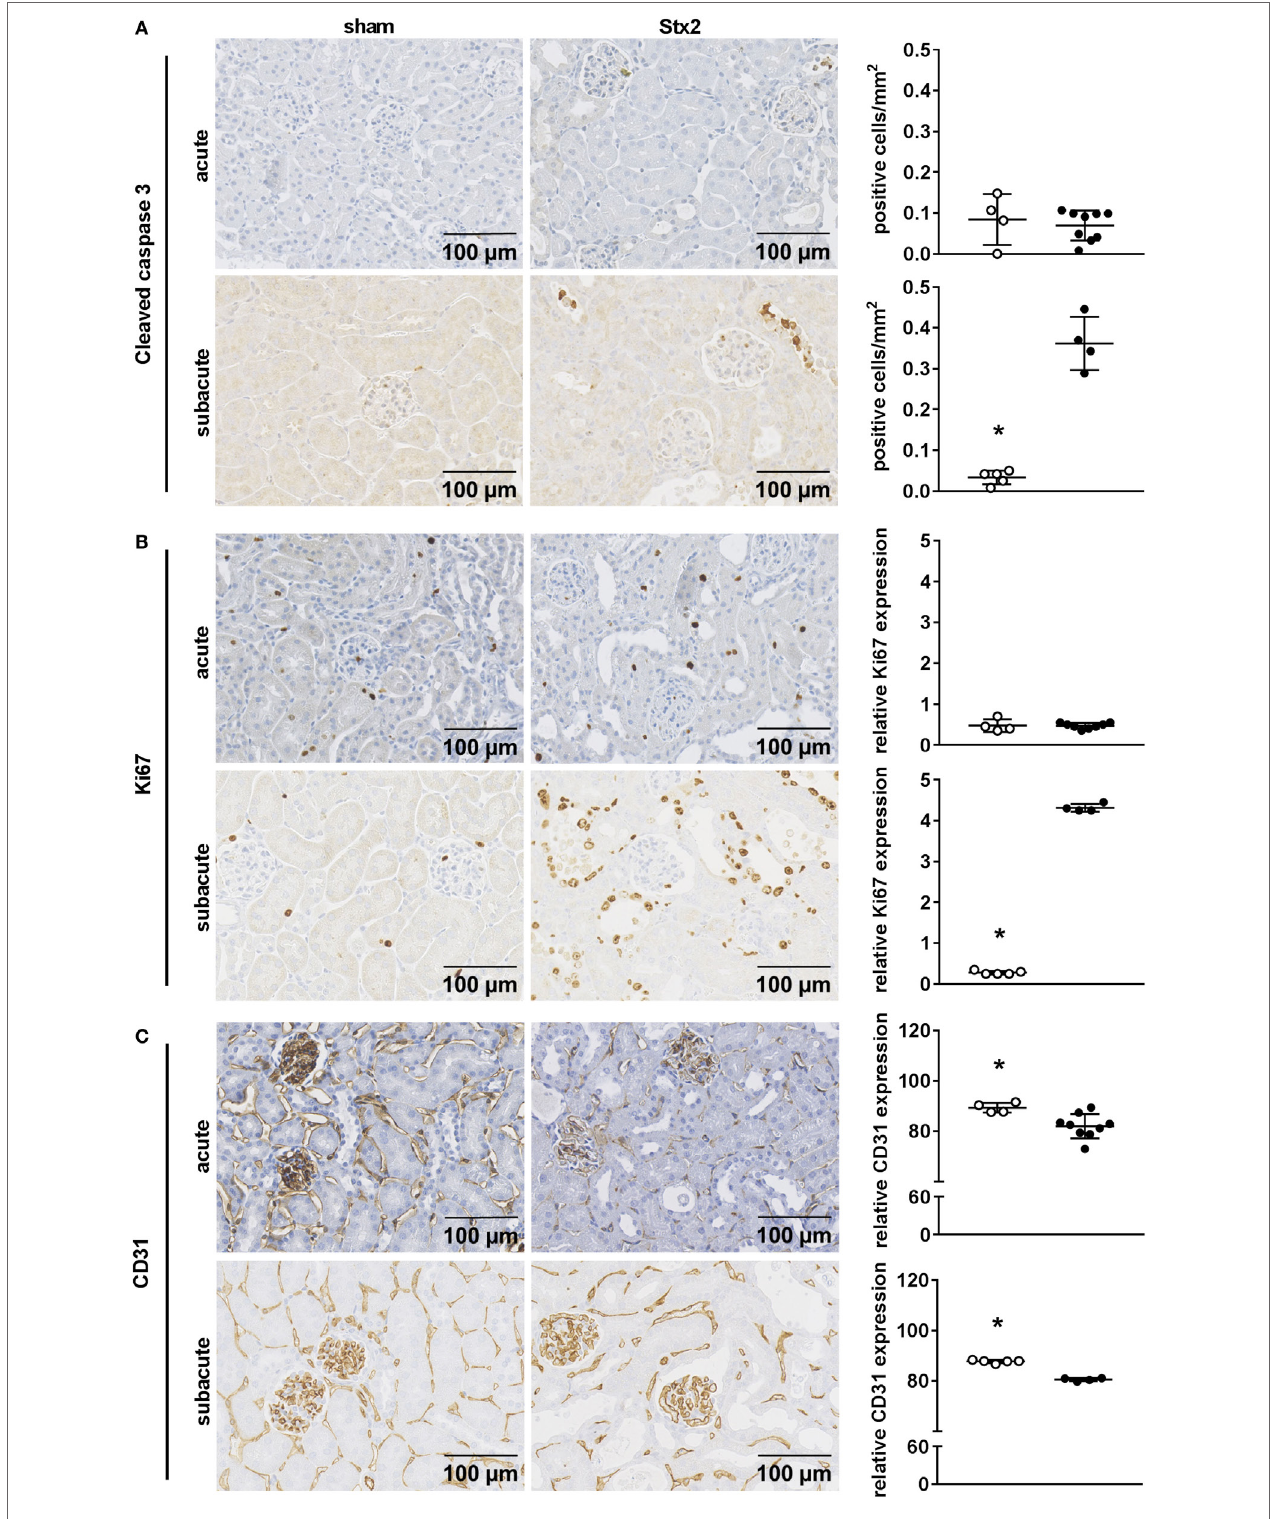
FigUre 7 | Indicators of cell death, reactive proliferation, and endothelial damage in kidney tissue of C57BL/6J mice subjected to different Stx2 regimens. Representative images of immunohistochemical detection and quantitative data of (a) cleaved caspase 3 (acute: sham n = 4, Stx2 n = 9; subacute: sham n = 5, Stx2 n = 3), (B) Ki67, and (c) CD31 (acute: sham n = 4, Stx2 n = 9; subacute: sham n = 5, Stx2 n = 4) in renal sections of C57BL/6J wild-type mice are depicted. * p < 0.05 for sham (white dots) vs. Stx2 (black dots; t